Question: Provide a one-line summary of what is displayed.
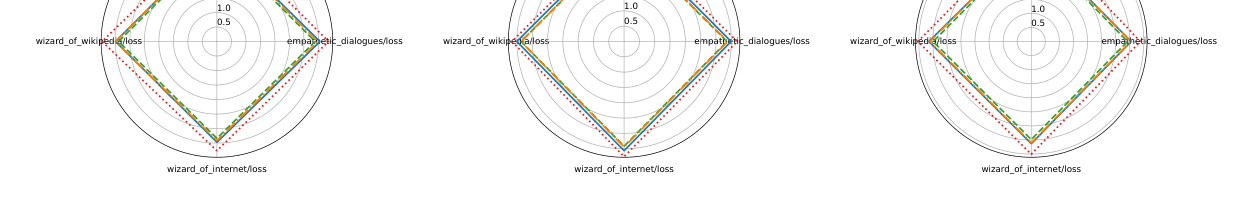
Answer: The average loss across the four dialogue tasks. From left to right: unlearning 8 samples, 16 samples, and 32 samples at once, respectively. Results based on the 1.3B checkpoint.